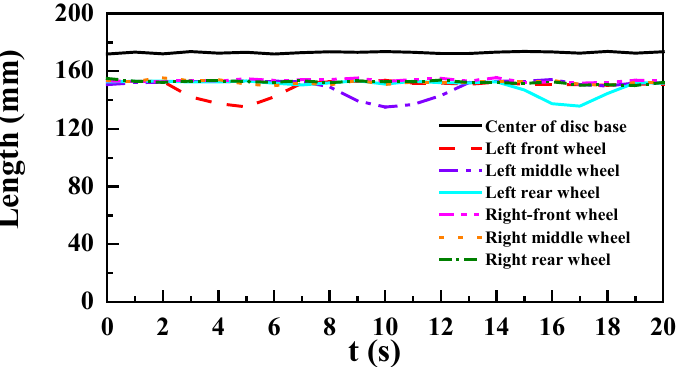
Figure 16. Movement tracks of plate and wheel center during one side obstacle crossing.